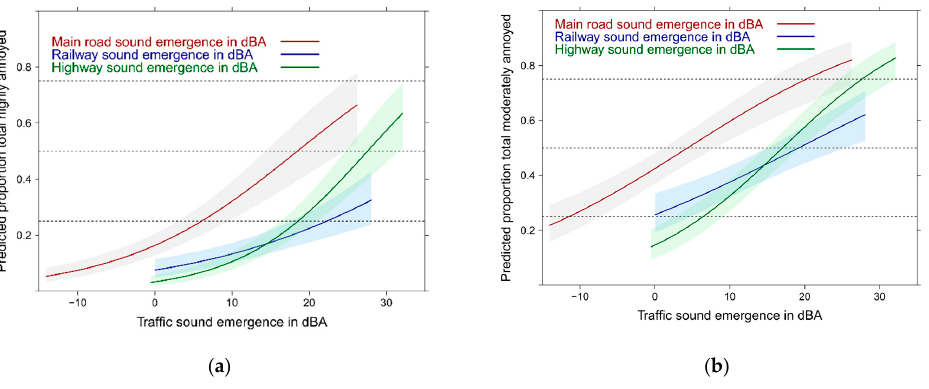
Figure 7. Predicted proportion of total annoyance associated with the emergence level of the sound sources (dBA). ( a ) Proportion highly annoyed; ( b ) Proportion moderately annoyed. Adjusted for age, sex, education, noise sensitivity, health status, and the other sound sources.